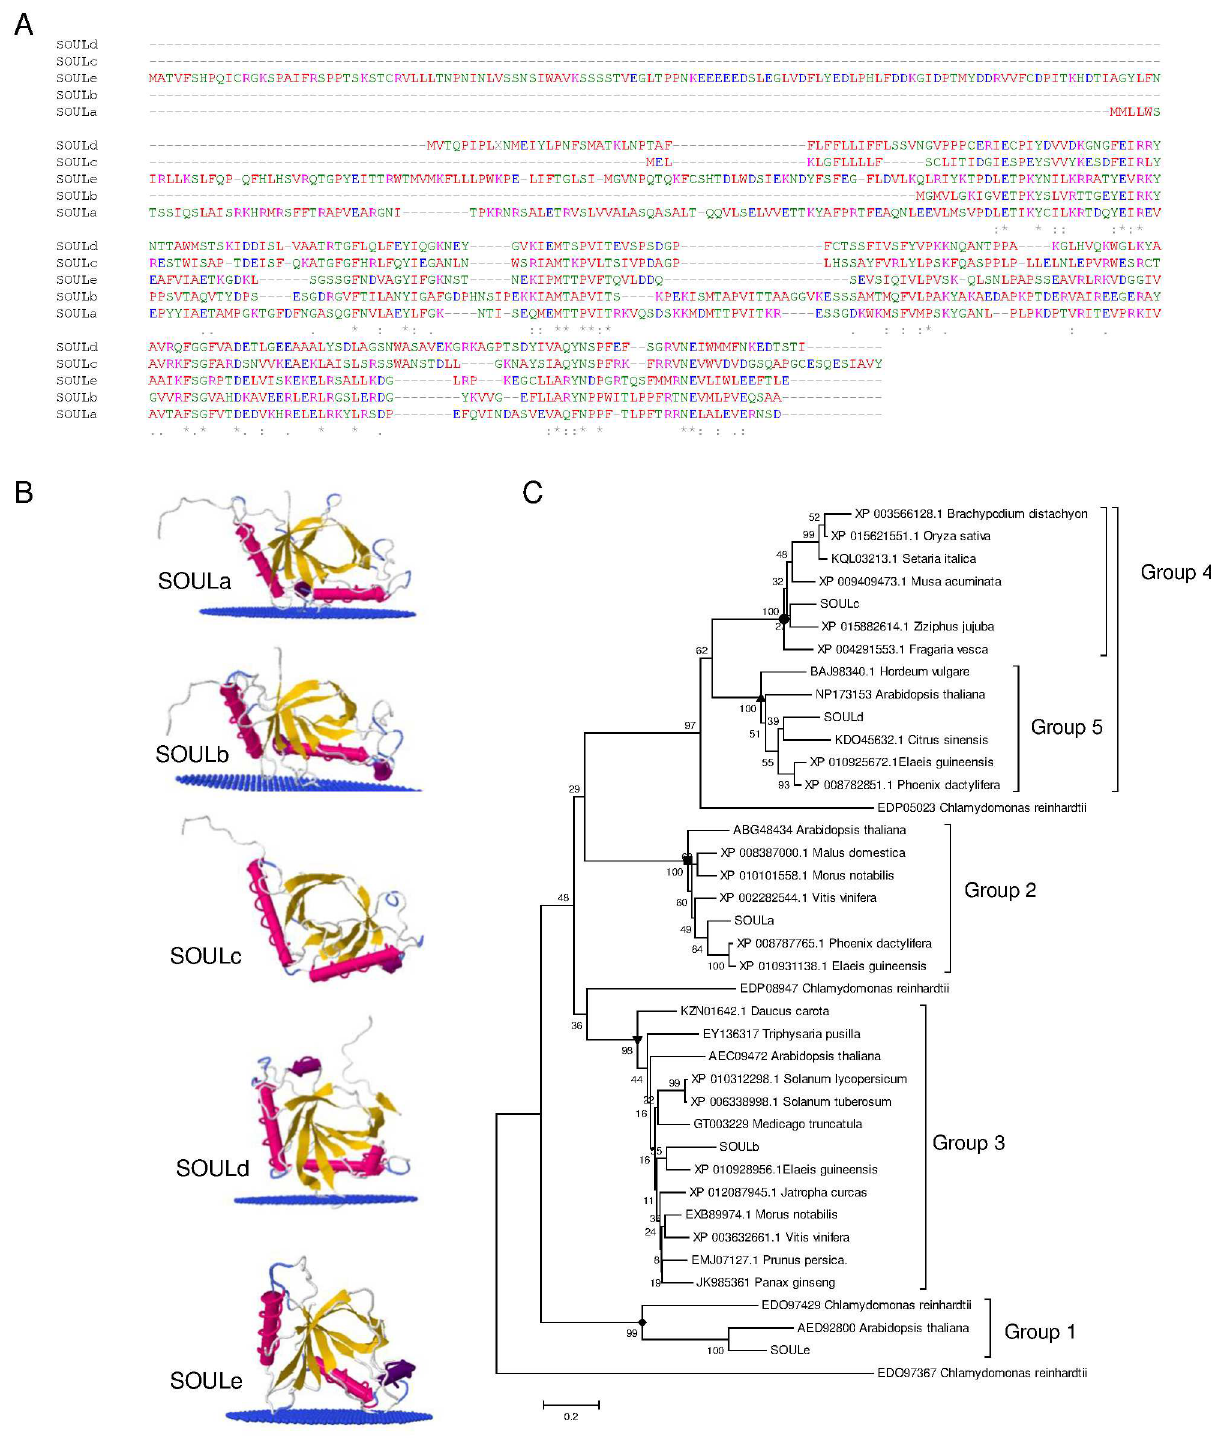
Fig 4. Comparison and analysesof SOUL proteins from saffron. (A) Amino acid alignmentof the five SOUL proteins isolated from saffron stigmas. Conservedresiduesare depictedwith asterisk. The colors of the residuesreflect their physicochemicalproperties:red for small (small+ hydrophobic (incl. aromatic -Y)); blue, acid; magenta, basic—H; green, Hydroxyl+ sulfhydryl+ amine + G. (B) Tridimensional models of SOULa-e and their dispositionin the membrane. (C) Phylogenetic analysisof SOUL proteins. An un-rootedphylogenetic tree was constructed using MEGA6 software with the neighbor-joining method basedon ClustalW multiplealignments. The percentages of replicate trees in which the associatedtaxa clusteredtogether in the bootstraptest (2,500 replicates)are shown next to the branches. The sequences isolated in this study are groupedin the red